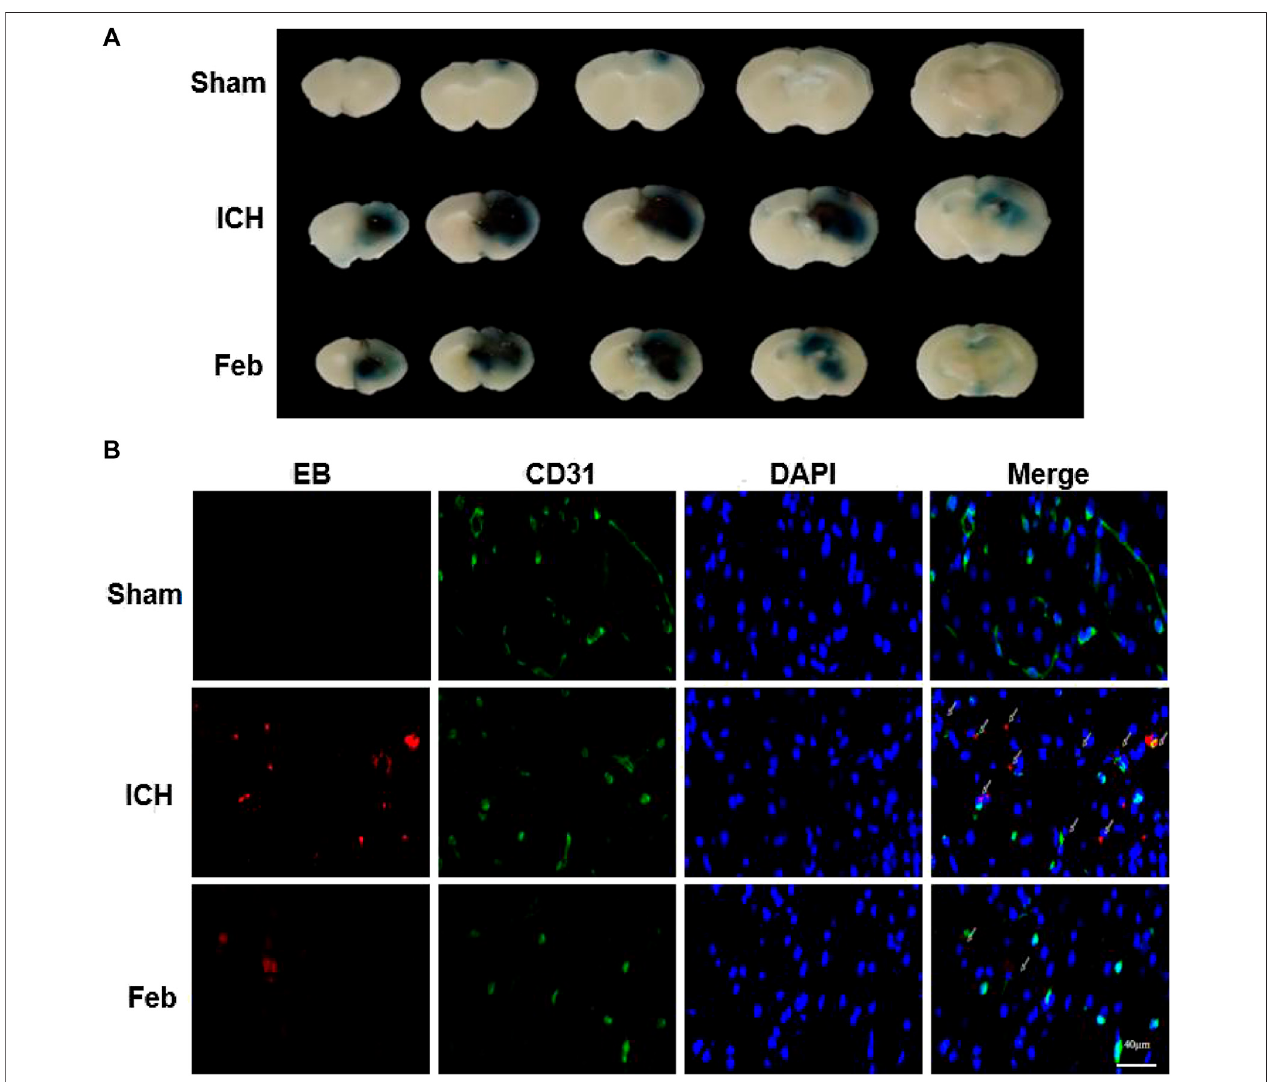
FIGURE 3 | Febuxostat attenuated BBB permeability after ICH: (A) Representative coronal brain sections show Evans blue extravasation. (B) Permeability of the BBB using theEvansBlue (EB) assay. EBis shown in red. CD31 isshown ingreen. White arrows indicate colocalization. Sections were stained with DAPI (blue) to show all nuclei. The scale bar is 40 μ